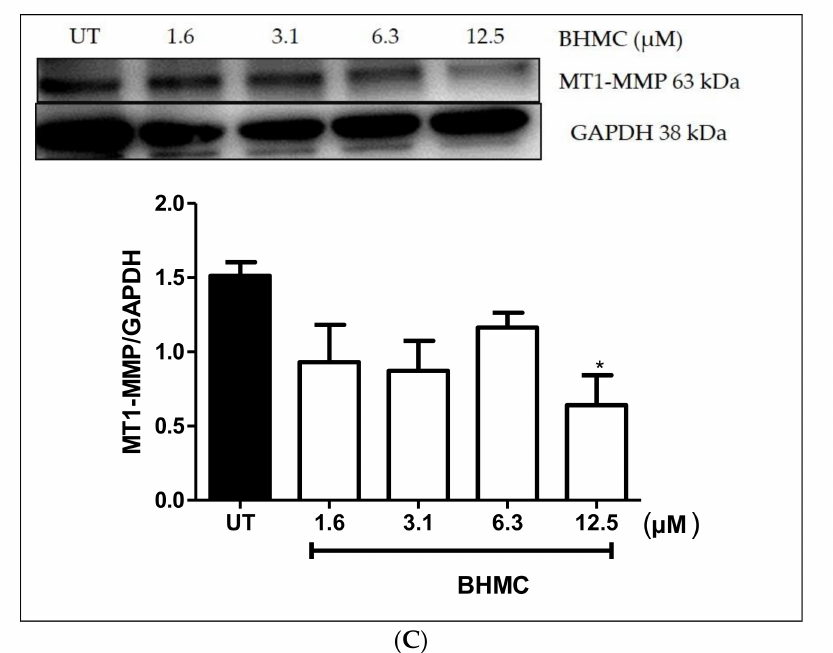
Figure 4. Effects of BHMC on β -PIX, MMP-9, MT1-MMP, protein expression. MDA-MB-231 cells were treated with indicated concentrations of BHMC for 24 h. Cell lysates were probed with ( A ) β -PIX, ( B ) MMP-9, and ( C ) MT1-MMP and normalized to Glyceraldehyde-3-phosphate dehydrogenase (GAPDH) level. All data are the mean ± S.E.M of three independent experiments. * p < 0.05, ** p < 0.01 and *** p < 0.001, which is significantly different from the untreated